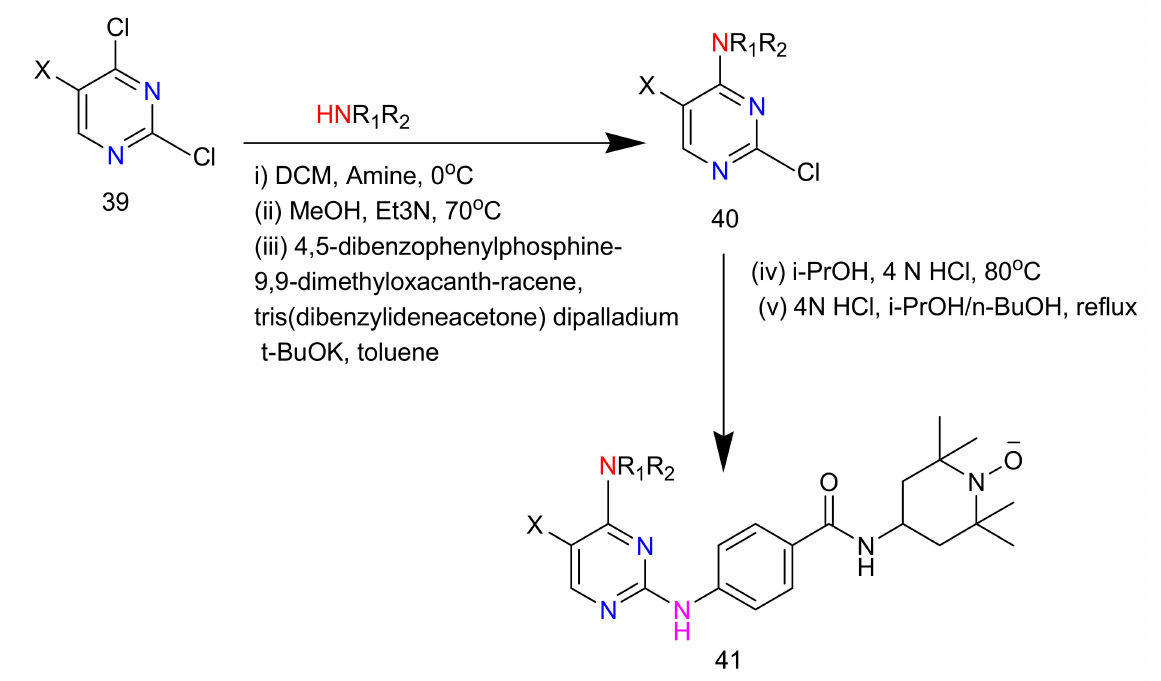
Scheme 14. Synthesis of 2,4-diaminopyridine scaffolds using 2,4-dichloro-5-fluoropyrimidine or 2,4-dichloro-5- nitropyrimidine [56]. Table 2. AK inhibition studies of N-trisubstituted